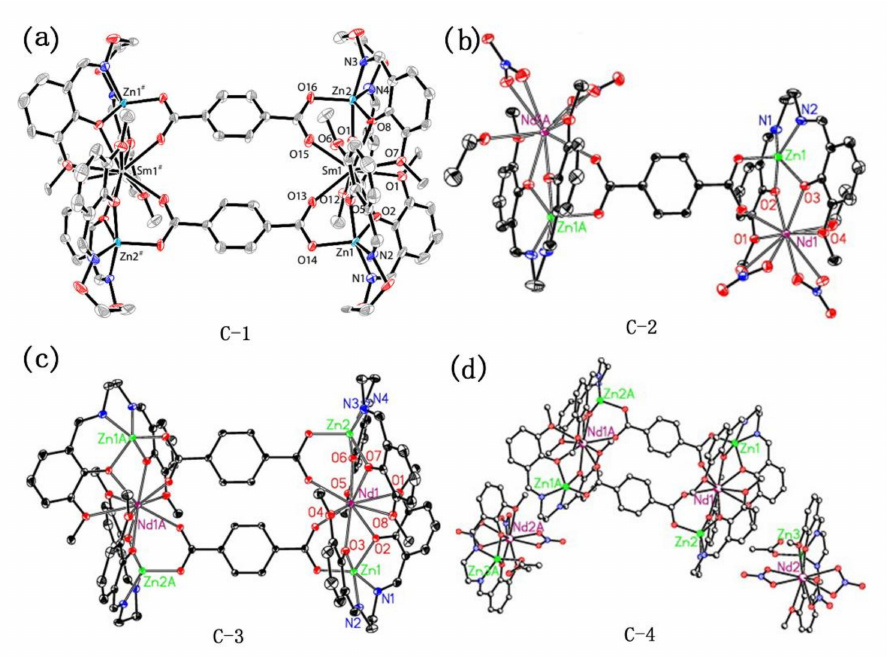
Figure 11. A view of the molecular structures of complexes ( a ) C-1 ; ( b ) C-2 ; ( c ) C-3 ; ( d ) C-4 . ( a ) Reprinted with permission from [52]. Copyright 2016, American Chemical Society; ( b – d ) Reprinted from [63]. Copyright 2009, with permission from